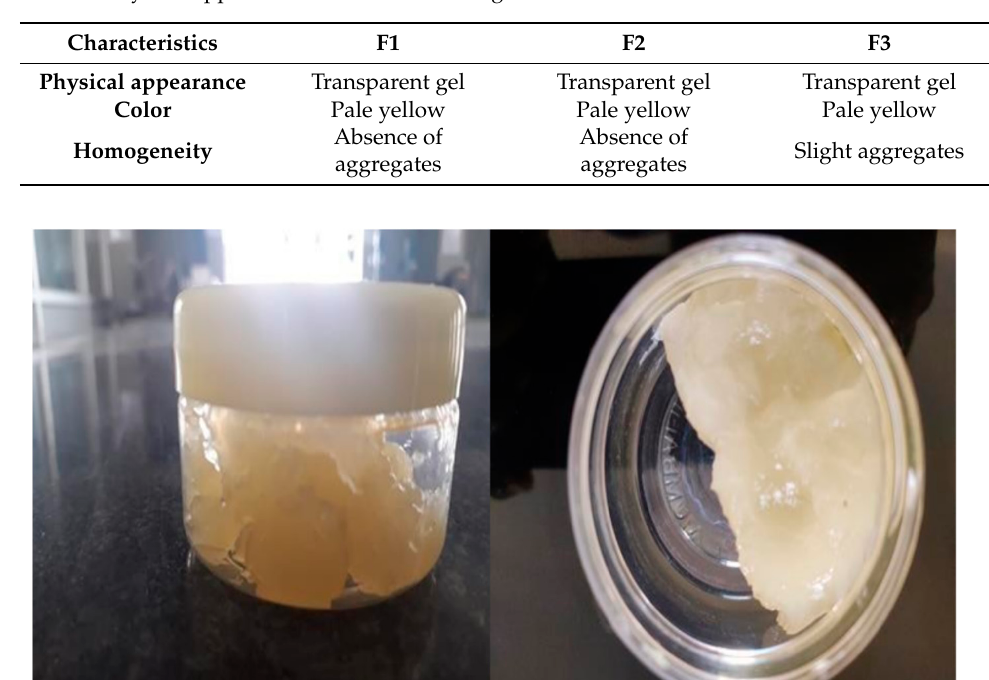
Table 6. Physical appearance of the formulated gel.